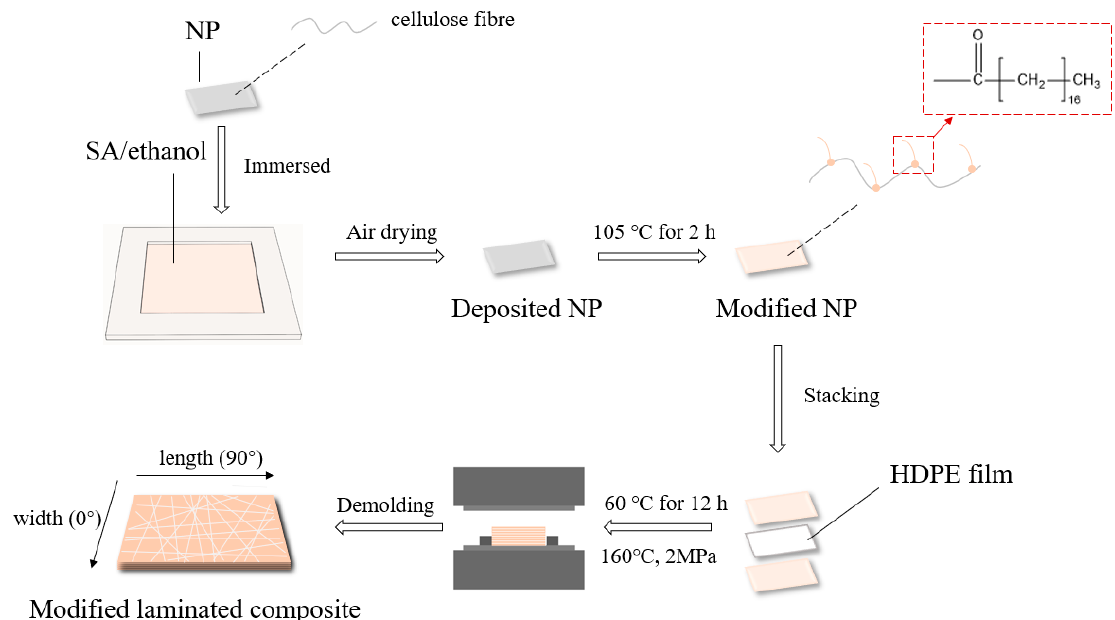
Scheme 1. Formation illustration of the hydrophobic NP and composite fabrication